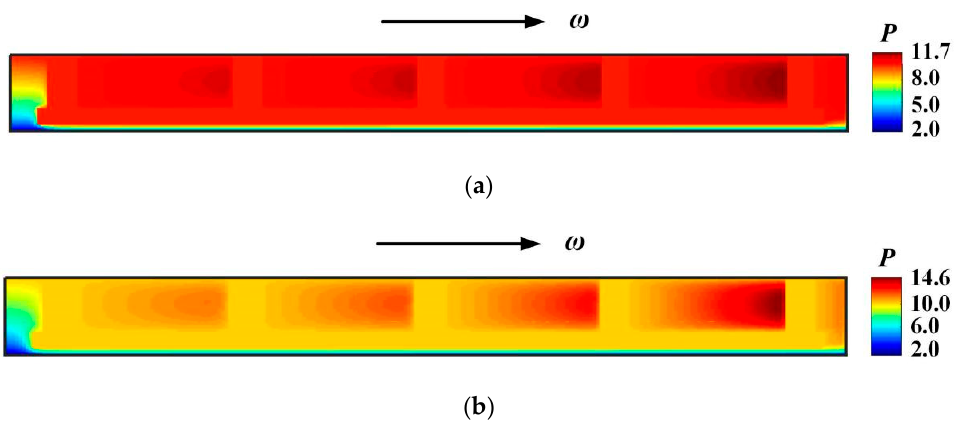
Figure 11. Pressure distribution at different deflection angles. ( p i = 1.0 MPa, ω = 3.0 × 10 4 r/min, T in = 580 K, T out = 380 K). (a) β = 6×10 − 6 rad; (b) β = 20×10 − 6 rad.